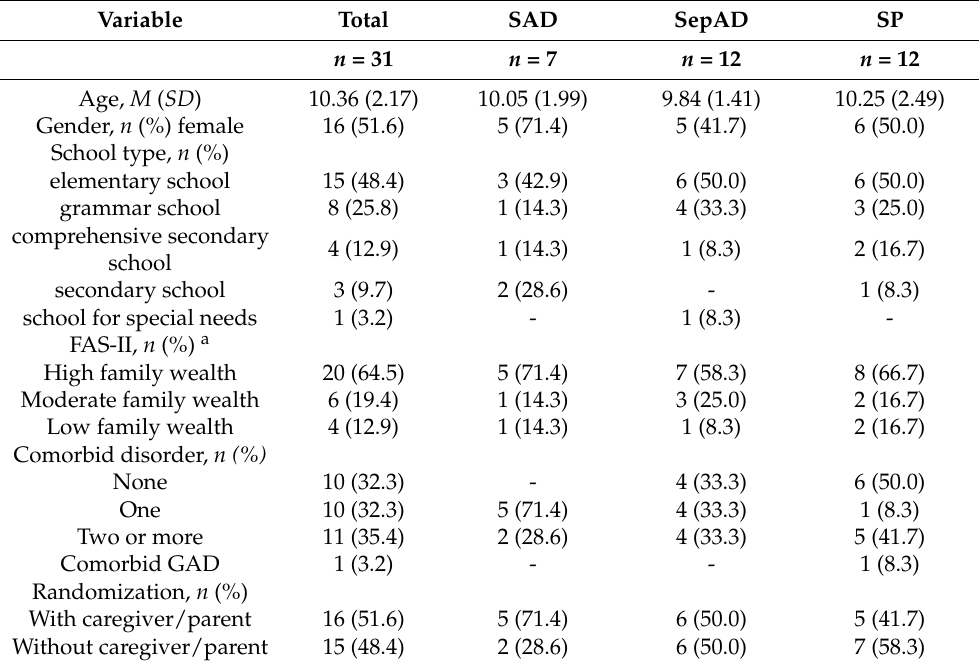
Table 1. Demographic